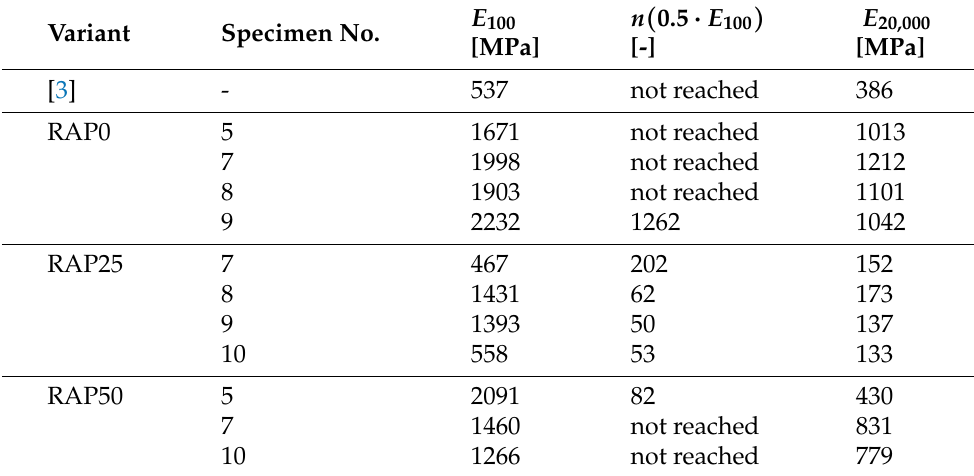
Table 3. Results of fatigue